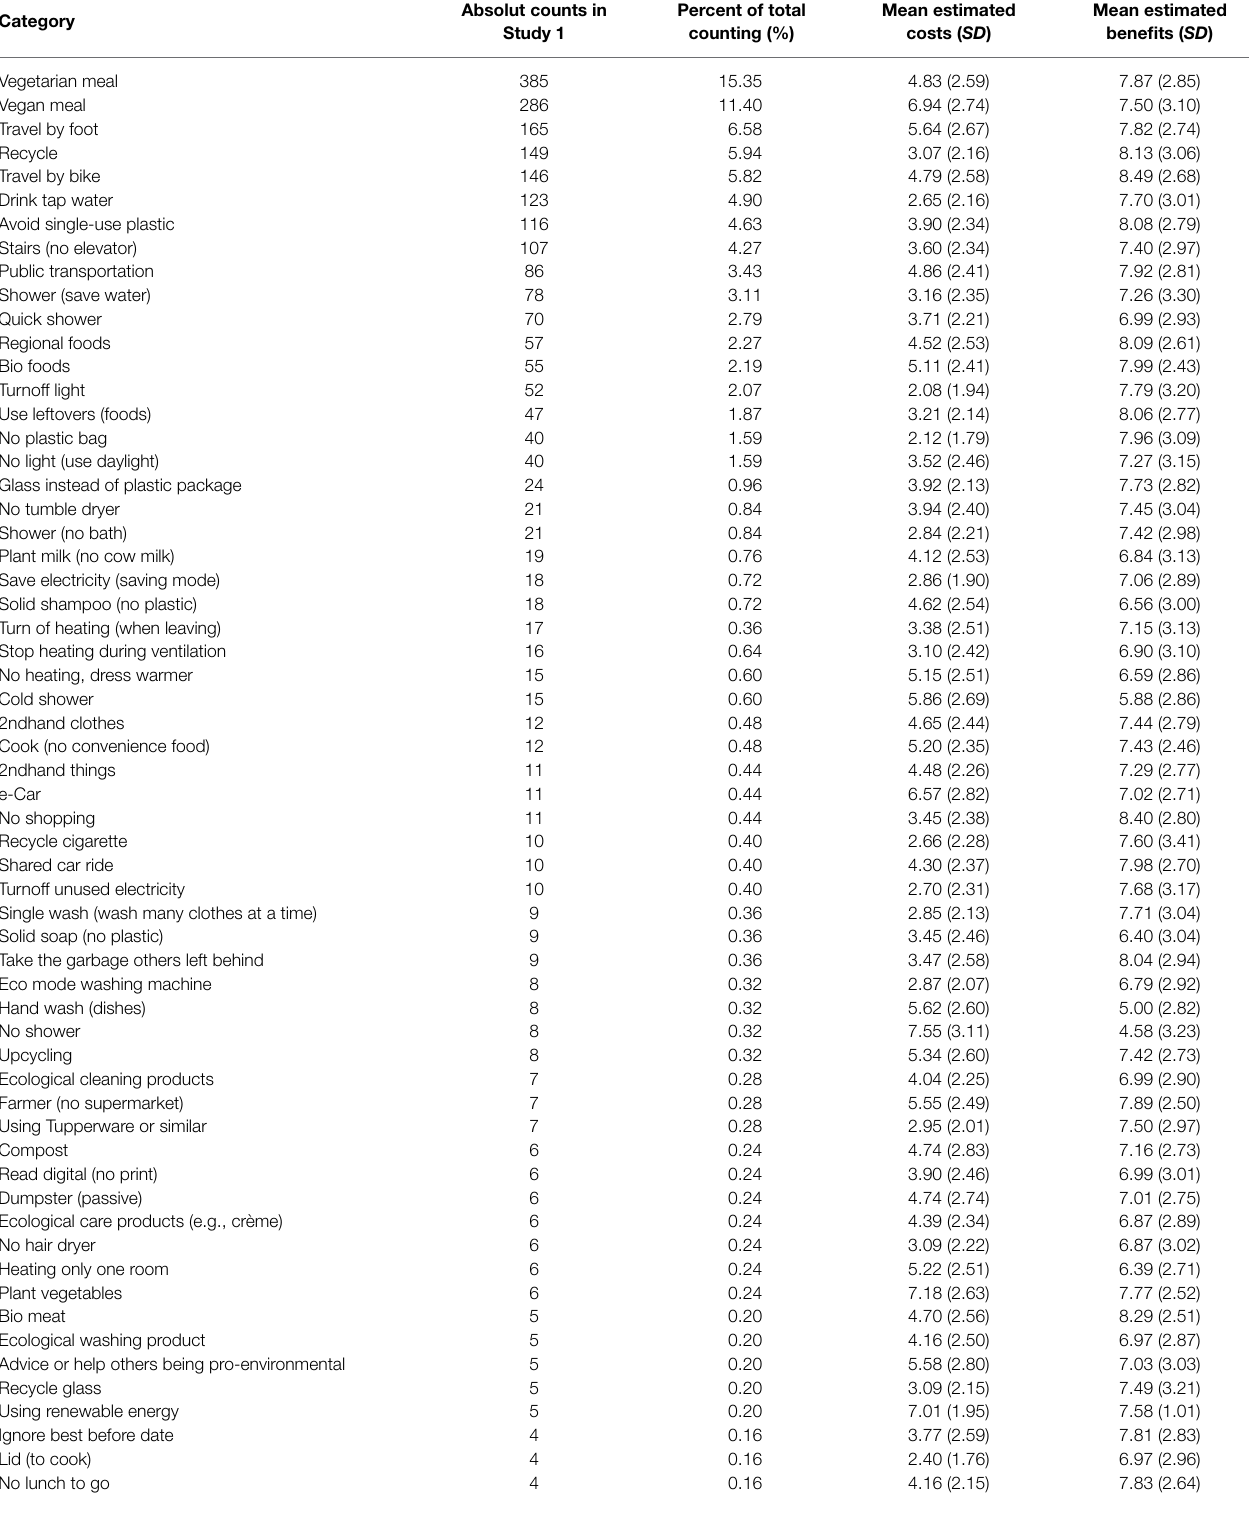
Absolut counts in Percent of total Mean estimated Mean estimated Study 1 counting (%) costs ( SD ) benefits ( SD )